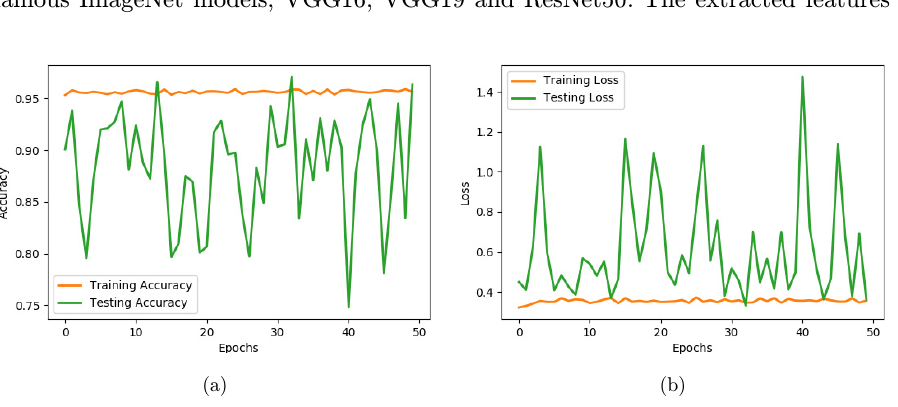
Fig. 7. Graph of the pretrained model with retraining: (a) Epochs vs. Accuracy graph (b) Epochs vs.